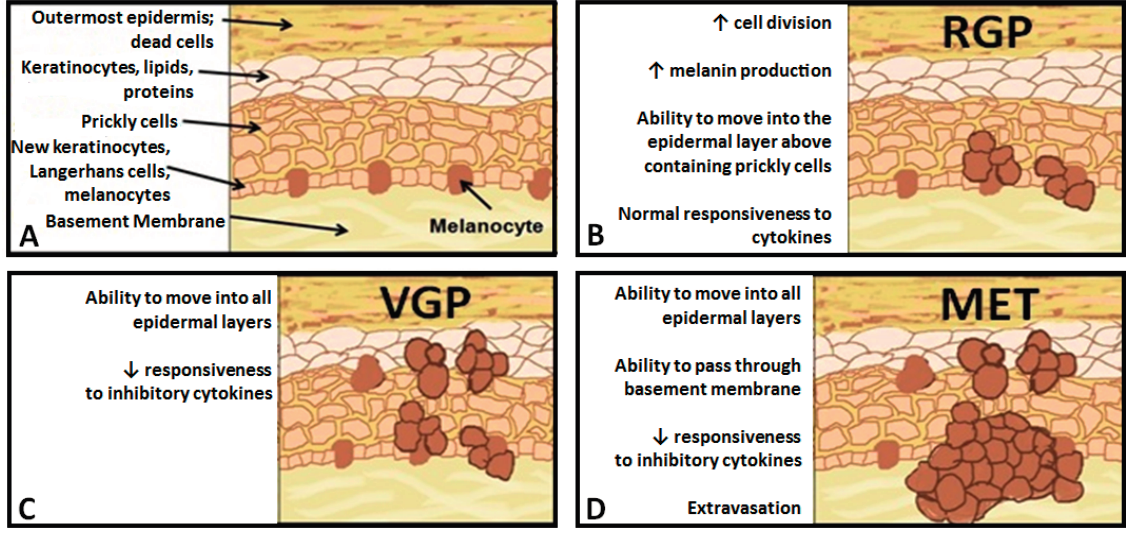
Figure 1. Representation of the progression from healthy melanocyte, to the radial growth phase (RGP), to the vertical growth phase (VGP), to metastatic (MET) melanoma. ( A ) Healthy melanocytes exist in a fixed ratio to keratinocytes in the basal layer of the epidermis; ( B ) RGP cells exhibit uncontrolled cell division and over-production of melanin; ( C ) VGP cells can spread throughout the epidermis and no longer respond to proliferation, inhibiting cytokines; and ( D ) MET cells are able to break through the basement membrane and enter the